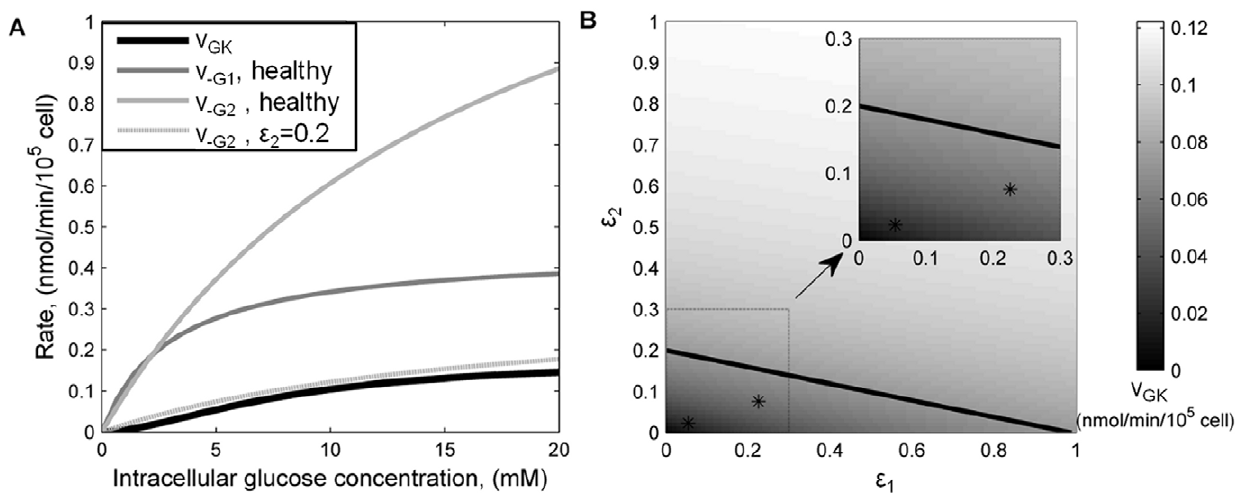
Figure 2. Comparison of glucose transport and phosphorylation in health and T2D b -cells. (A) GLUT-1 and GLUT-2 outwards rates ( v { G 1 and v { G 2 , respectively), and GK kinetics as a function of intra-cellular glucose concentration for normal ( e ~ 1 ) glucose transporters’ expression and reduced GLUT-2 expression ( e ~ 0 : 20 ). (B) Steady-state GK rate calculated at 16.8 mM extra-cellular glucose concentration as a function of concerted GLUT-1 and GLUT-2 deficiency. e 1 and e 2 are the fractions of GLUT-1 and GLUT-2, respectively, compared to normal. The solid line indicates the threshold between transport- and phosphorylation-limited G6P formation (derived in (A)), whereas asterisks indicate the positions of T2D patients b - cells. Inset represents an enlargement of the lower left region.